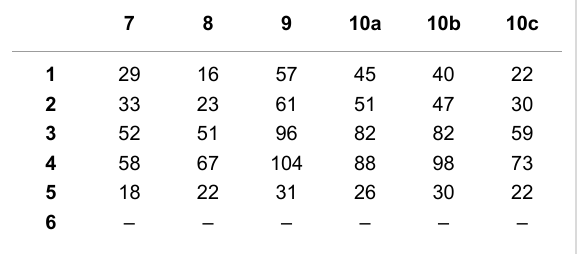
Table 7: Comparison of the uptake of VOCs for the amphiphilic coating and native β -CD in solution. The numbers are the ratio between the uptake of the ACD coating and the uptake of β -CD. Native β -CD did not remove any 6 from the gaseous